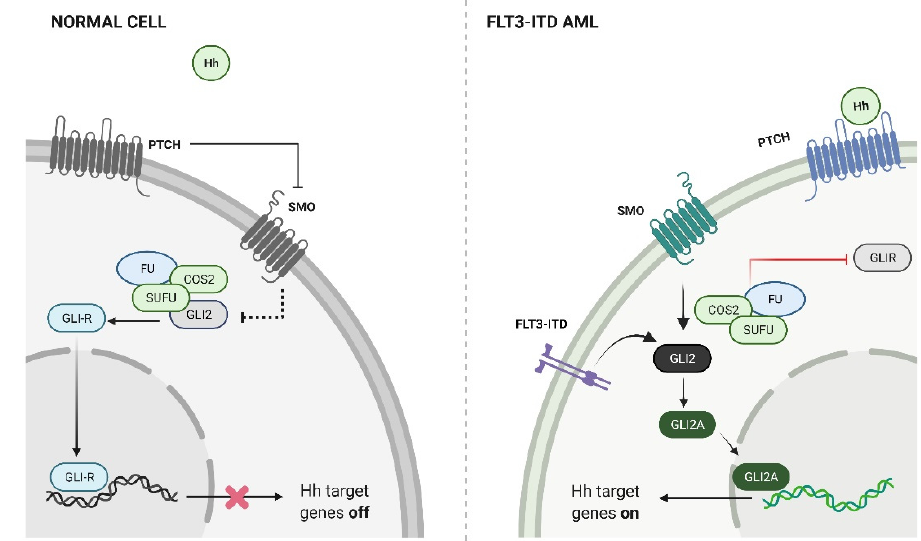
Figure 1. HH pathway activation in FLT3-ITD AML. Constitutive FLT3-ITD kinase activity induces the expression of GLI2, which permits responsiveness to HH ligands (illustrated using BioRender.com, accessed on 14 June 2021).